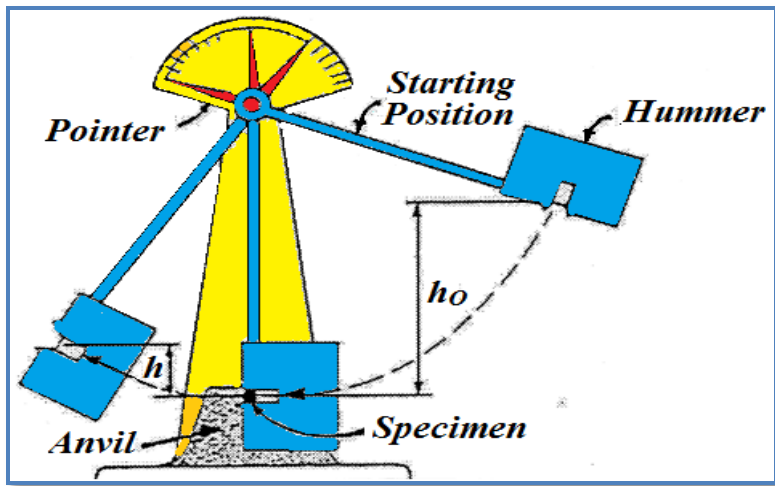
Fig.2: Shows impact strength diagram in a Charby